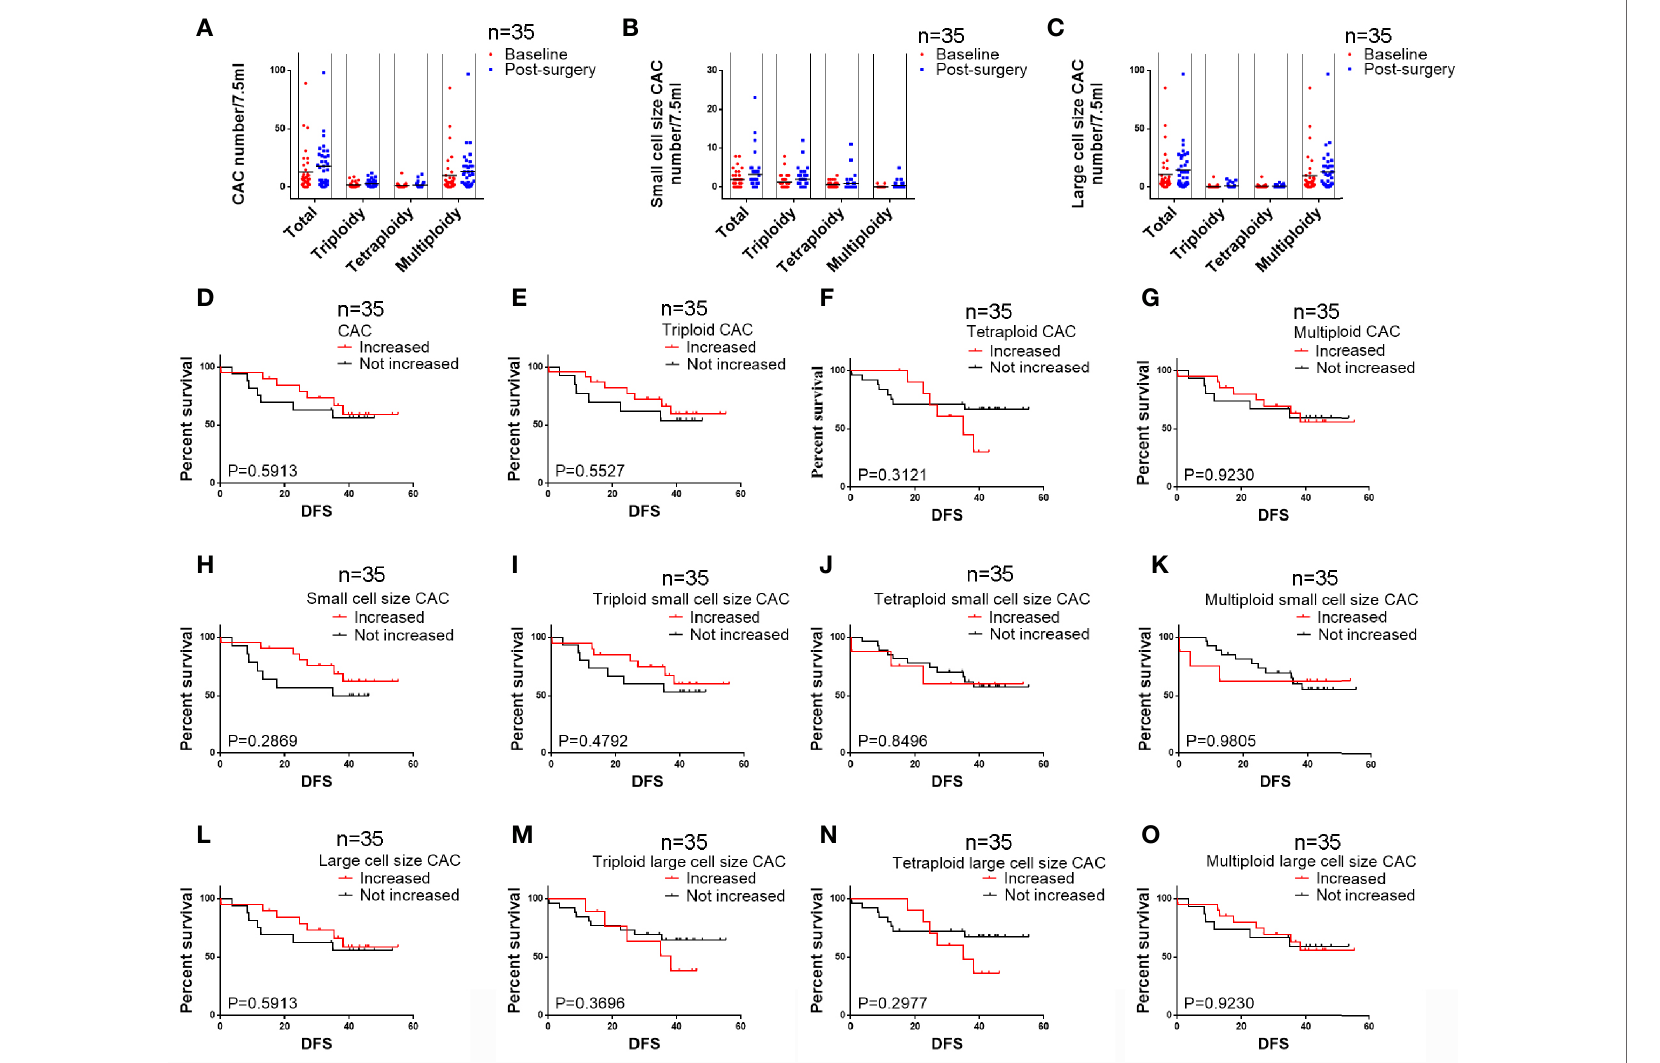
FIGURE 4 | Analysis of CAC pre- and post-surgery variation among 35 patients (A) Variation in numbers of total CACs and the three subtypes. (B) Variation in numbers of total small cell size CACs and the three subtypes. (C) Variation in numbers of total large cell size CACs and the three subtypes. (D – G) Variations in total CACs and the triploid, tetraploid, and multiploid subtypes were not correlated to DFS (P > 0.05). (H – K) Variations in total small cell size CACs and the triploid, tetraploid, and multiploid small cell size CAC subtypes were not correlated to DFS (P > 0.05). (L – O) Variations in total large cell size CACs and the triploid, tetraploid, and multiploid large cell size CAC subtypes were not correlated to DFS (P >